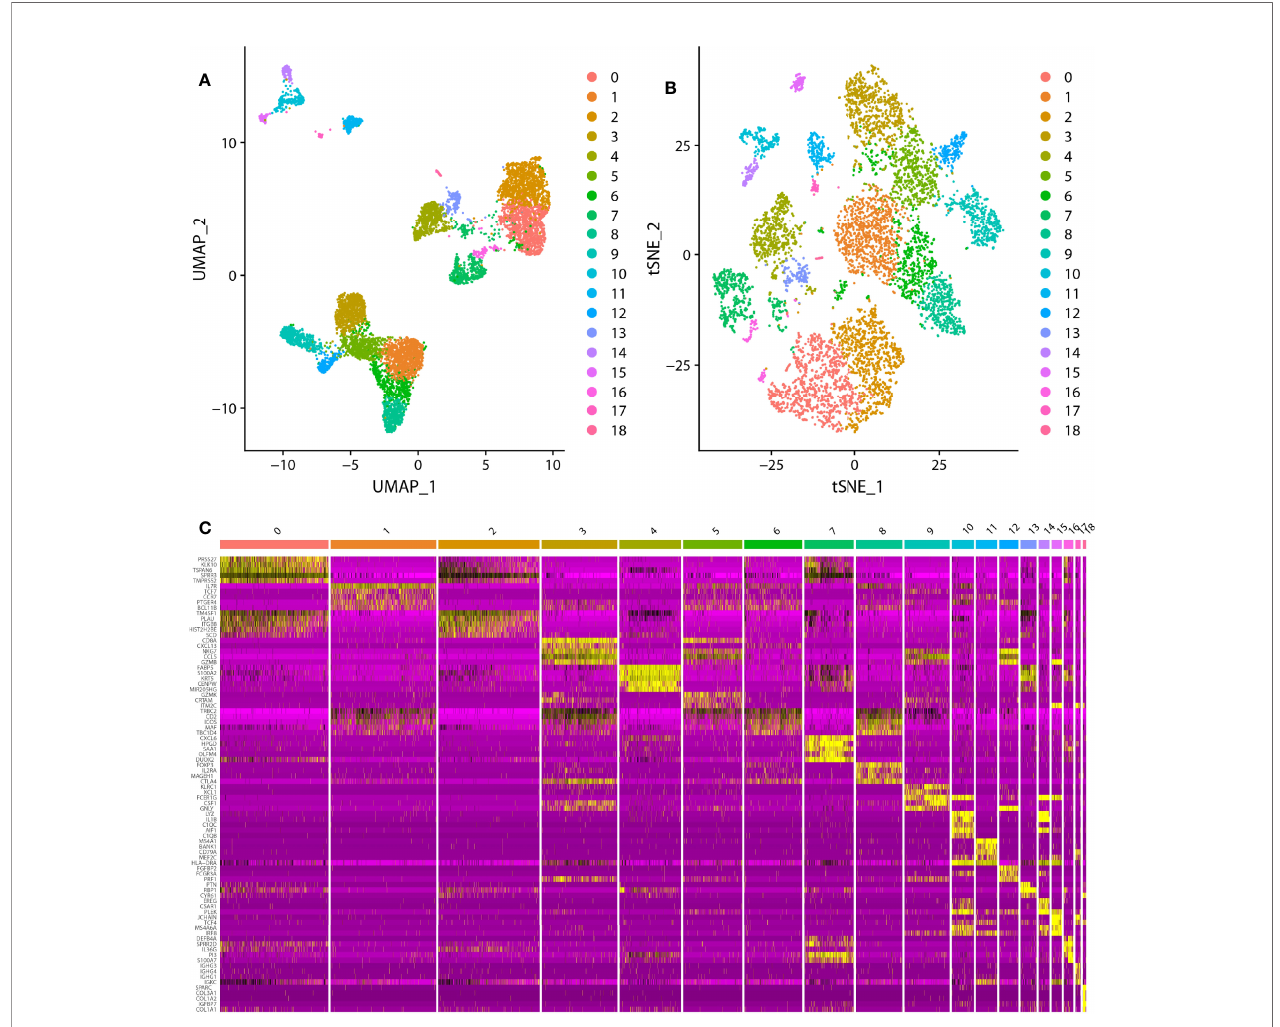
FIGURE 1 | The dimension reduction of CESC scRNA-seq. (A) Separate clusters according to UAMP. (B) Separate clusters according to tSNE. (C) Top fi ve marker genes of each